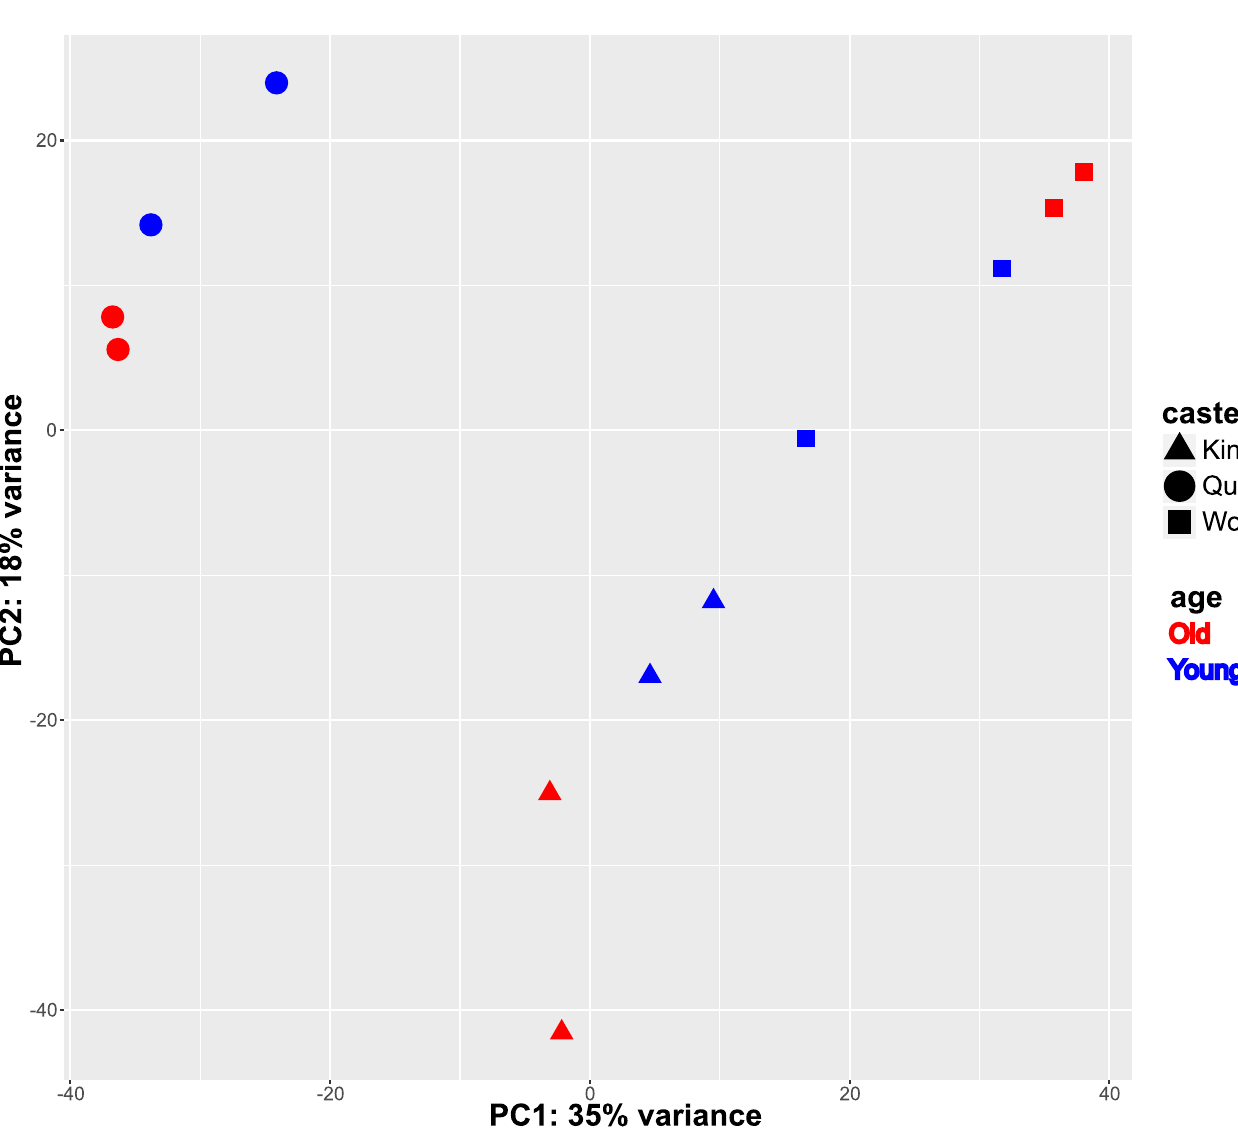
PLOS ONE | https://doi.org/10.1371/journal.pone.0210371 February 13,